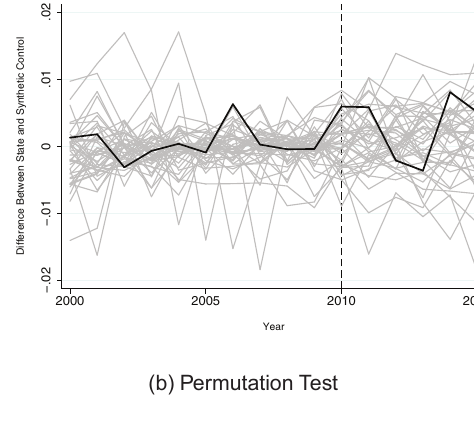
Figure A12 Utah universal e-verify and share of low-skilled immigrants in